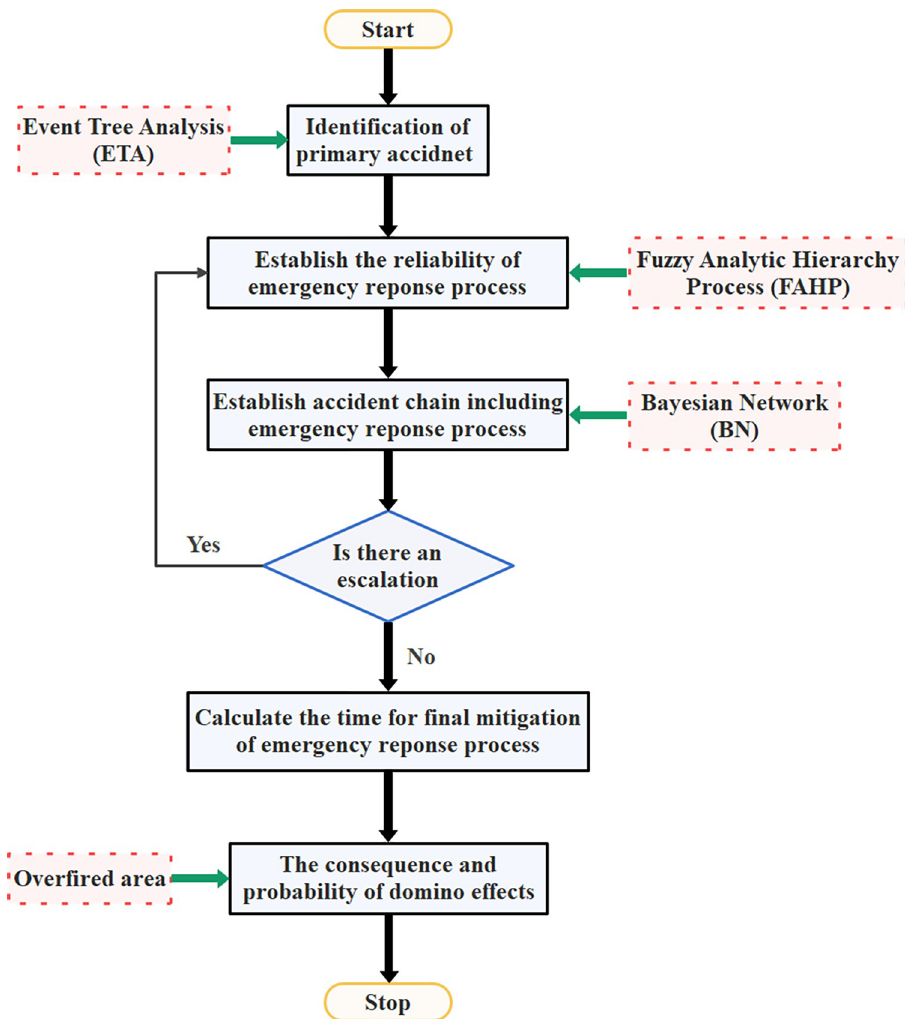
Fig 3. System flow diagram of the proposed